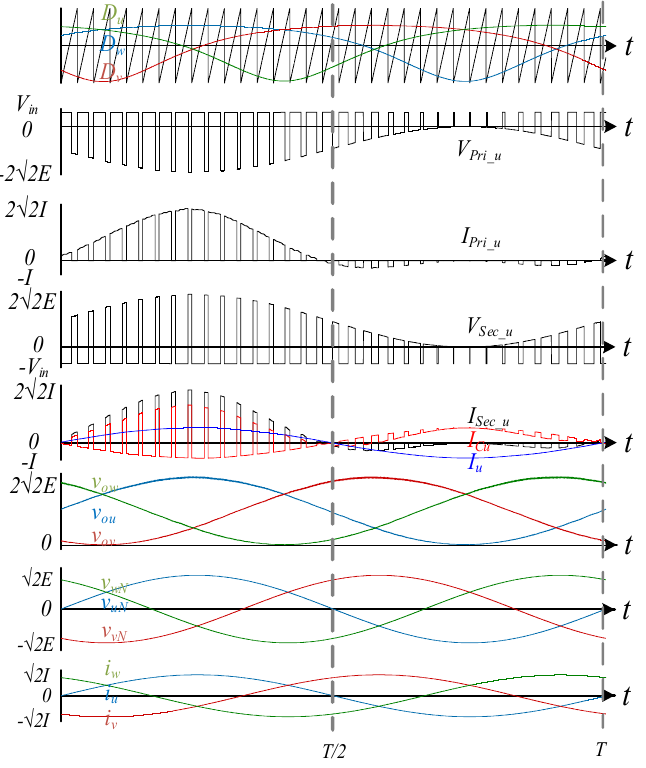
Figure 6. Switching waveforms of single flyback module of the proposed MFBDI.